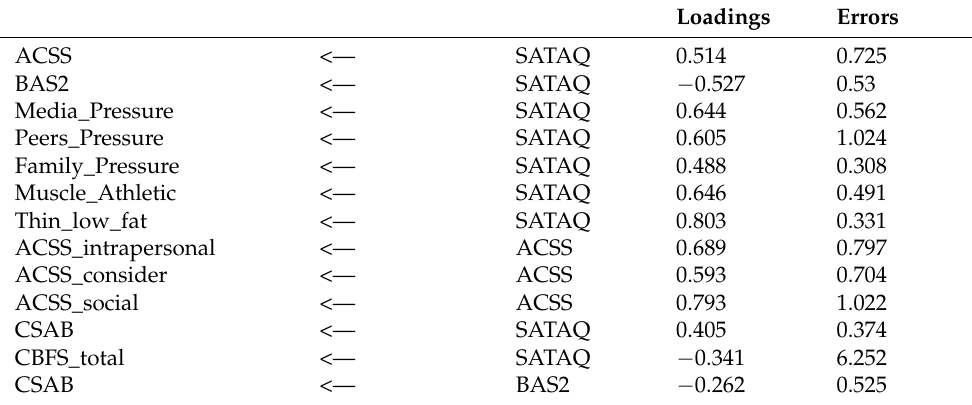
Table 6. Factor loadings and errors of constructs.